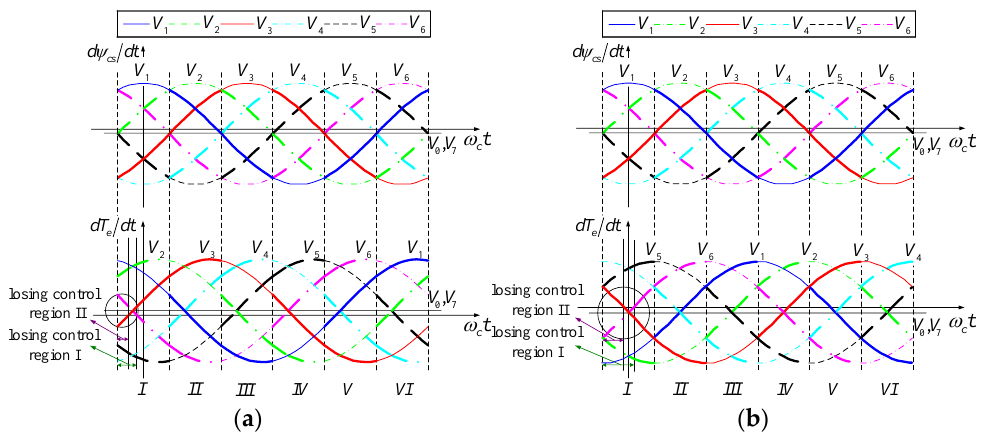
Figure 6. Stator flux of the CM and torque derivative curves (heavy load). ( a ) Motoring mode ( T e = 59 Nm); ( b ) Generating mode ( T e = −99 Nm).